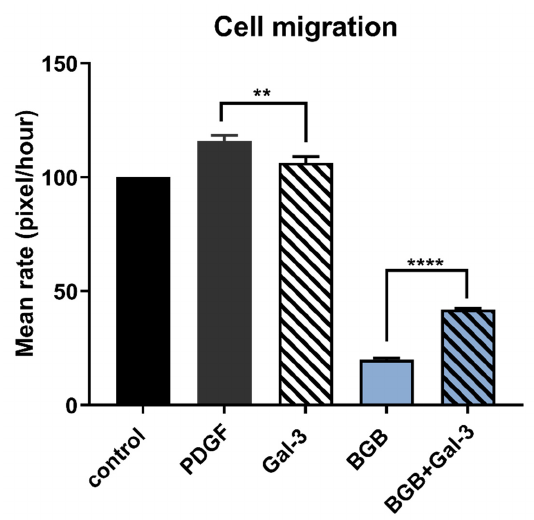
Figure 8. E ff ect of Gal-3 on cell migration. Cell migration rate of SCC-25 cells in scratch wound assay, expressed as a percentage vs. the control (untreated). Cells were treated with PDGF (10 nM) as a positive control, Gal-3 (0.2 µ M), Axl inhibitor BGB324 (BGB; 10 µ M) and a combination of both Gal-3 and BGB324. The averages of gap distance at 0 and 21 h and the gap closure rate were calculated for each set of treatments. Data are the mean ± SEM and underwent ANOVA with Tukey’s multiple comparison post-hoc analysis; **** p < 0.0001, ** p < 0.01 for comparisons indicated by lines ( n = 4 experiments).